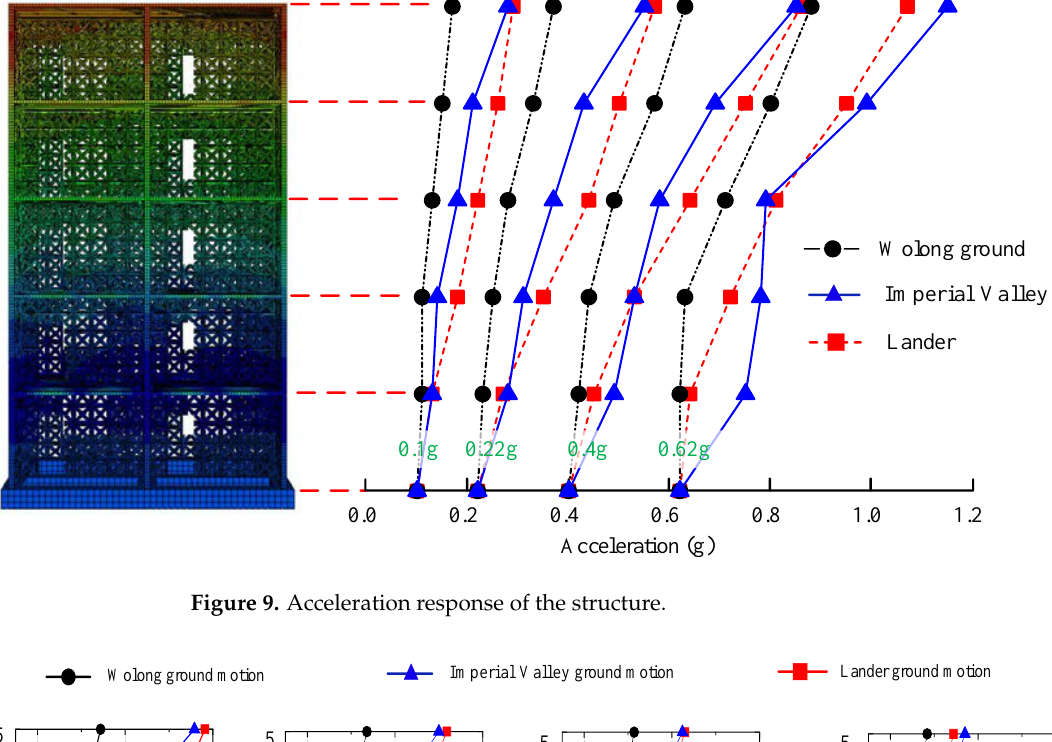
Figure 9. Acceleration response of the structure.